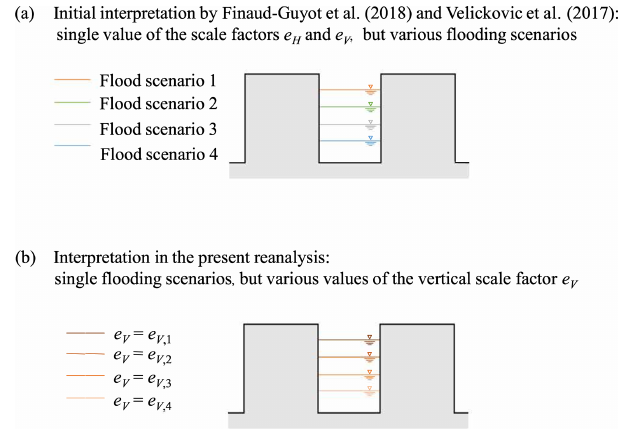
Figure 2. (a) Sketch of the initial interpretation of the laboratory model runs as various flooding scenarios represented with fixed scale factors. (b) Sketch of the interpretation in the present reanal- ysis, involving a single flood scenario represented with various ver- tical scale factors e V